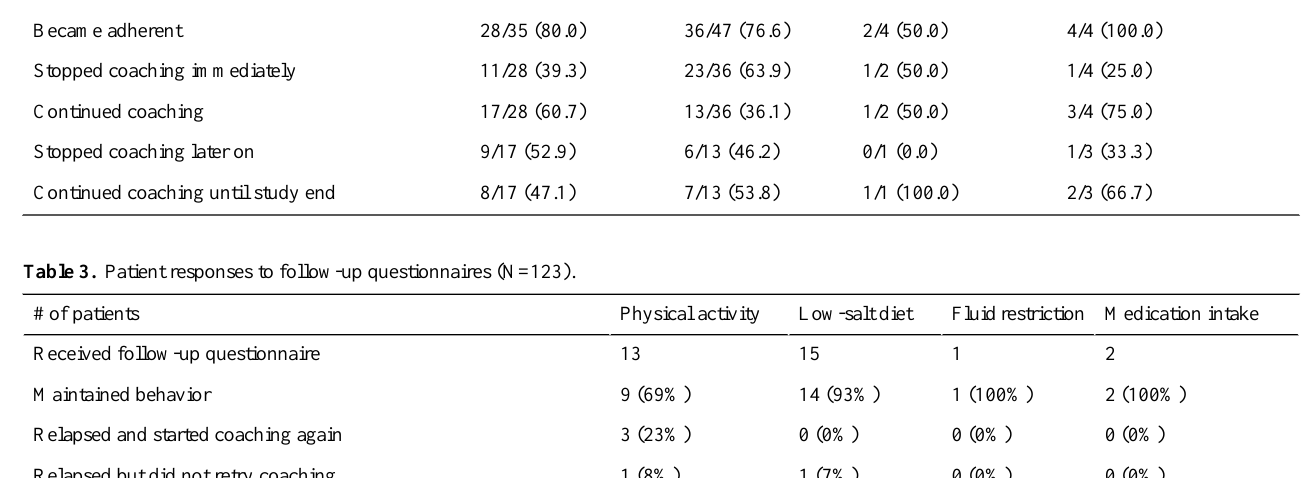
211513Received follow-up questionnaire